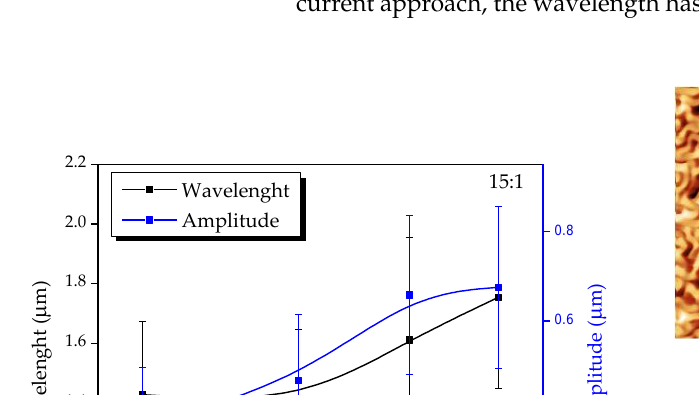
Figure 7. Time dependence of the changes concerning ( a ) QCM thickness and ( b ) ellipsometric measurement upon cycling exposure; Table 3. 3 and 6.5 for two hydrogels (10:1 and 15:1).